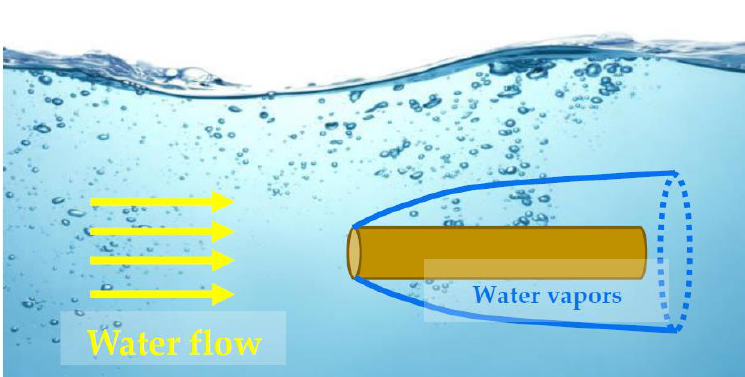
Figure 1. A scheme of the physical